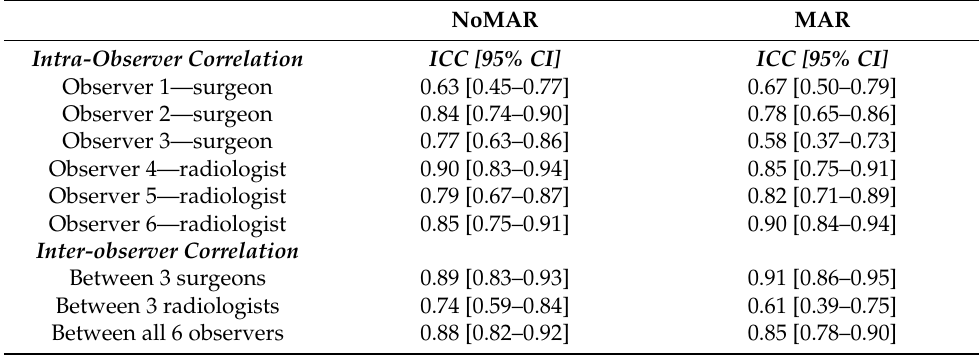
Table 1. Intra-class correlation coefficients and 95% credible intervals for the Gertzbein–Robins classification without (NoMAR) and with metal artifact reduction algorithm (MAR).